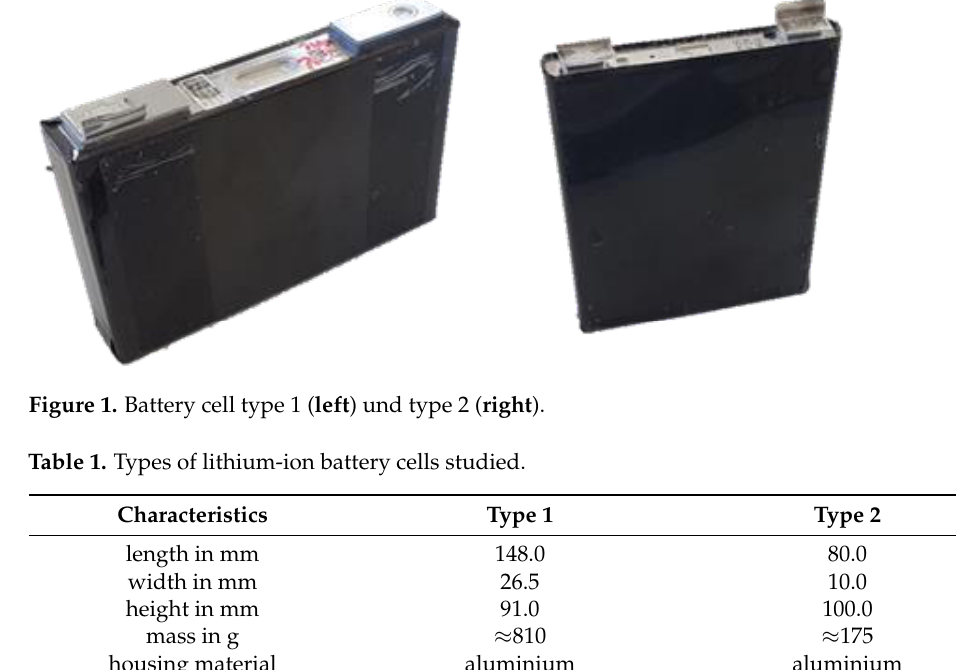
Figure 1. Battery cell type 1 ( left ) und type 2 ( right ).